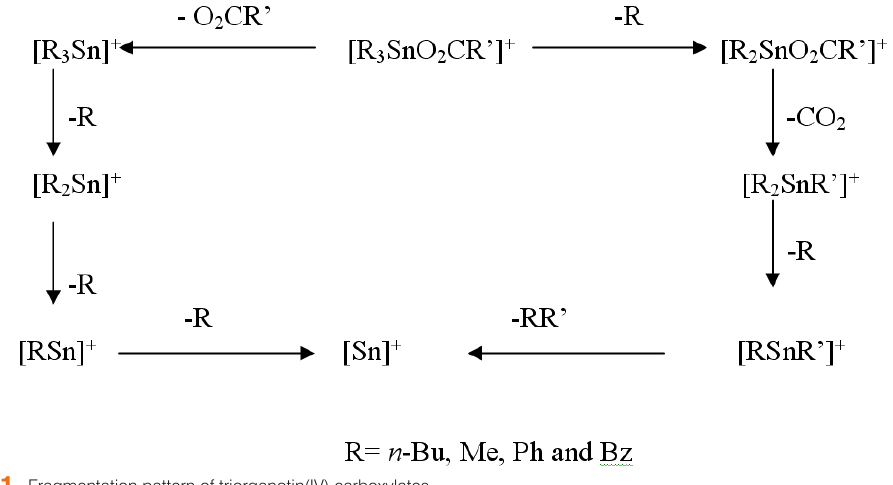
Scheme1. Fragmentation pattern of triorganotin(IV) carboxylates.